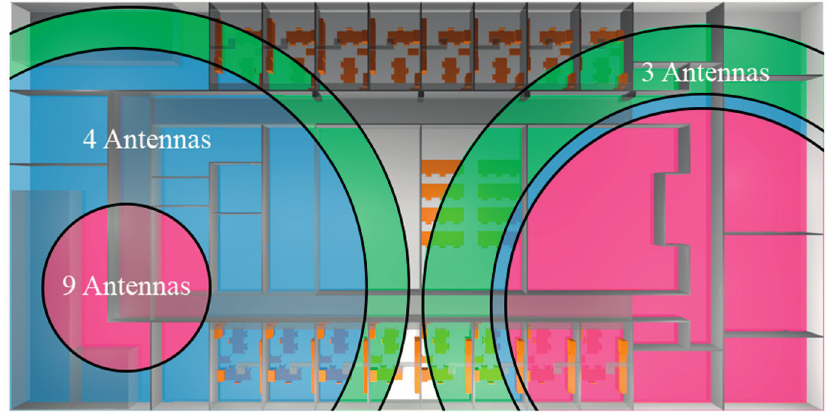
Figure 10. Approach to the maximum emitting distance for three configurations of